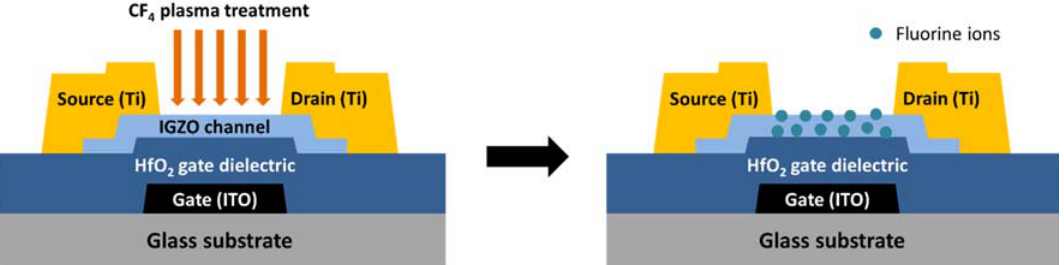
Figure 1. Schematic cross ‐ sectional diagrams of a ‐ IGZO TFT with CF 4 plasma treatment.